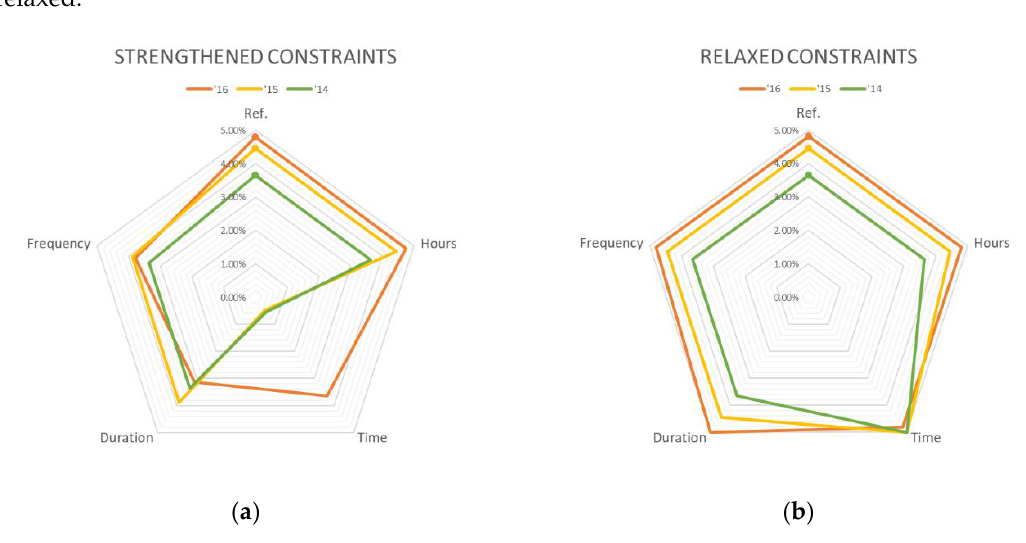
Figure 1. Average contribution in initial sensitivity simulation: ( a ) With strengthened constraints; ( b ) With relaxed constraints.